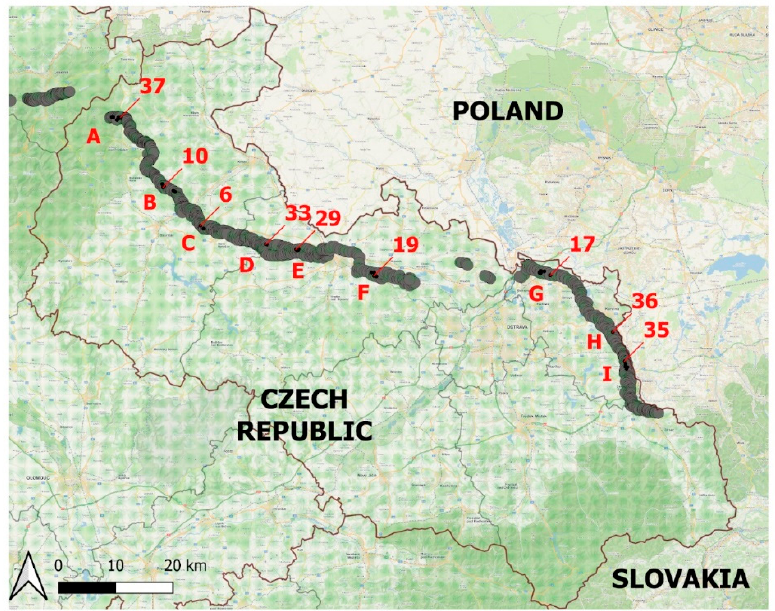
Figure A2. Situation of A-CEFs and corresponding sections of SA-CEFs (from A to I) in the borderlands of the Moravian-Silesian Region [28,33–35].